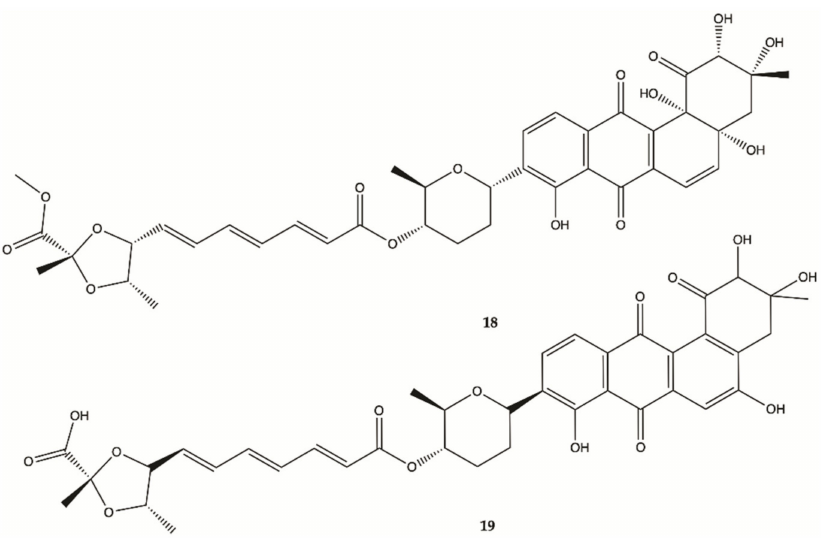
Figure 8. Fradimicins 18 and 19 isolated from Streptomyces fradiae PTZ0025 [47]. Streptoglutarimides 20 and 21 (Figure 9) were isolated from an actinomycete, Strep- tomyces sp. ZZ741. They showed potent antiproliferative activity against human glioma U87MG and U251 cells with IC 50 values of 1.5–3.8 µ M for 19 and 0.05–0.22 µ M for 20 [48].